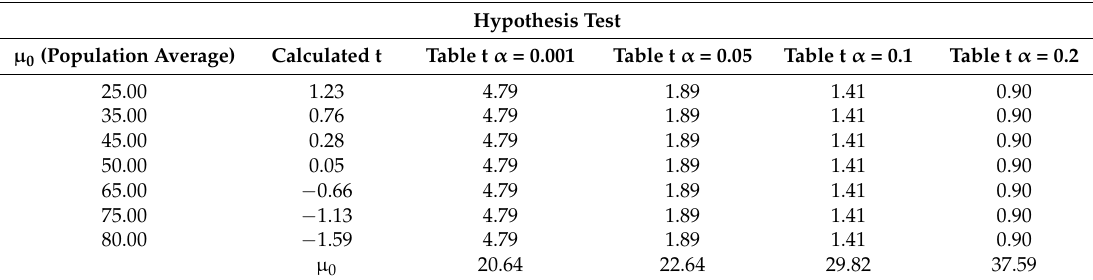
Table 4. Application of t-student test to iron content